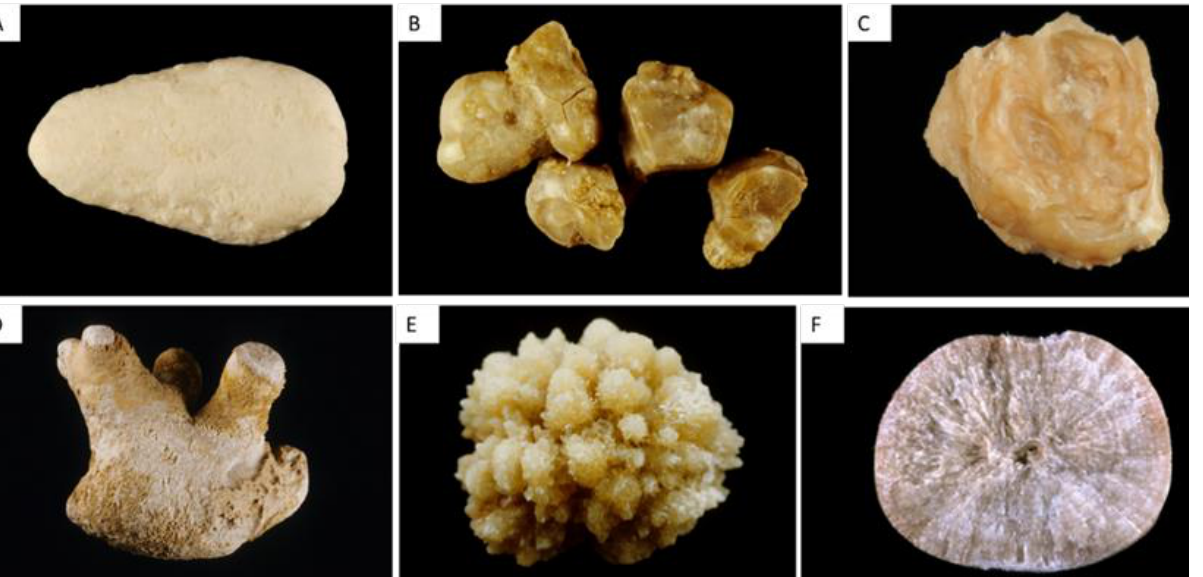
Figure 4. Type IV stones, made of calcium phosphate(s) or struvite. ( A ) Type IVa1 stone with a homogeneous smooth surface. ( B , C ) Type IVa2 stone surface and section, with yellow-brown and glazy surface with cracks, and a section showing irregular yellow-brown concentric layers. ( D ) Type IVb complex stone, made of carbapatite admixed with other calcium phosphates or struvite. Type IVb stones have a heterogeneous surface, embossed and rough, and a clear to dark brown color. ( E , F ) Type IVd stone surface and section showing slightly rough surface resembling a cabbage, whitish to beige, and a section showing radial crystallization with locally concentric layers.